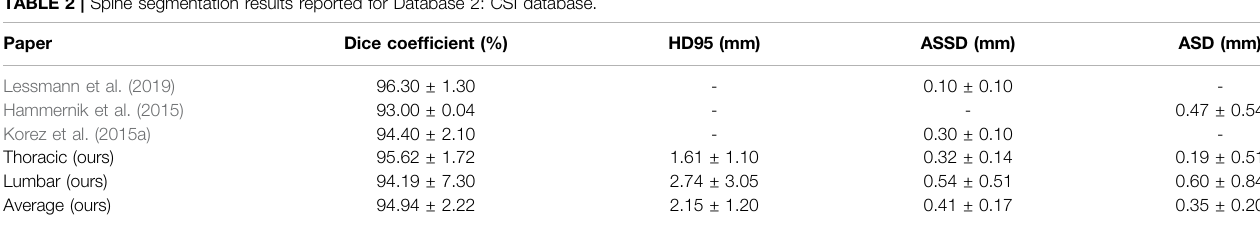
TABLE 2 | Spine segmentation results reported for Database 2: CSI